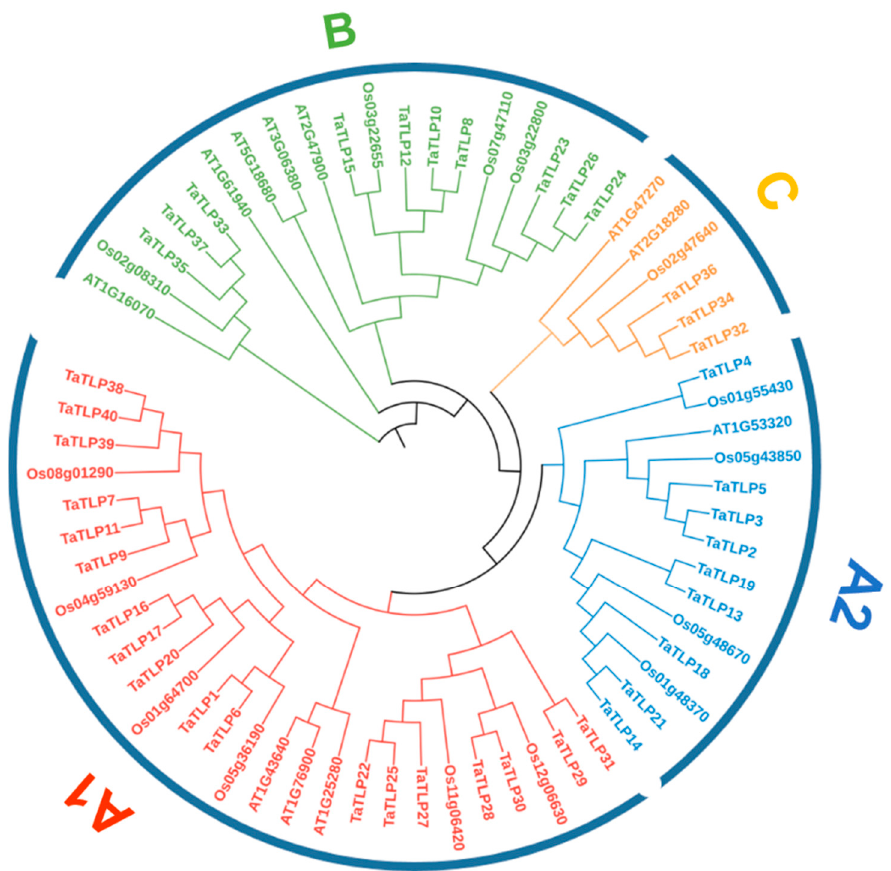
Figure 1. TLPs protein phylogeny in three plants: T. aestivum, A. thaliana , and O. sativa . MEGA 7 was used to generate the phylogenetic tree using the following parameters: Bootstrap D 1000 replicates, Neighbor-Joining method, Poisson correction. All group members are divided into four groups, each represented by an assorted color. Different labels are used to identify members of various spe- cies.